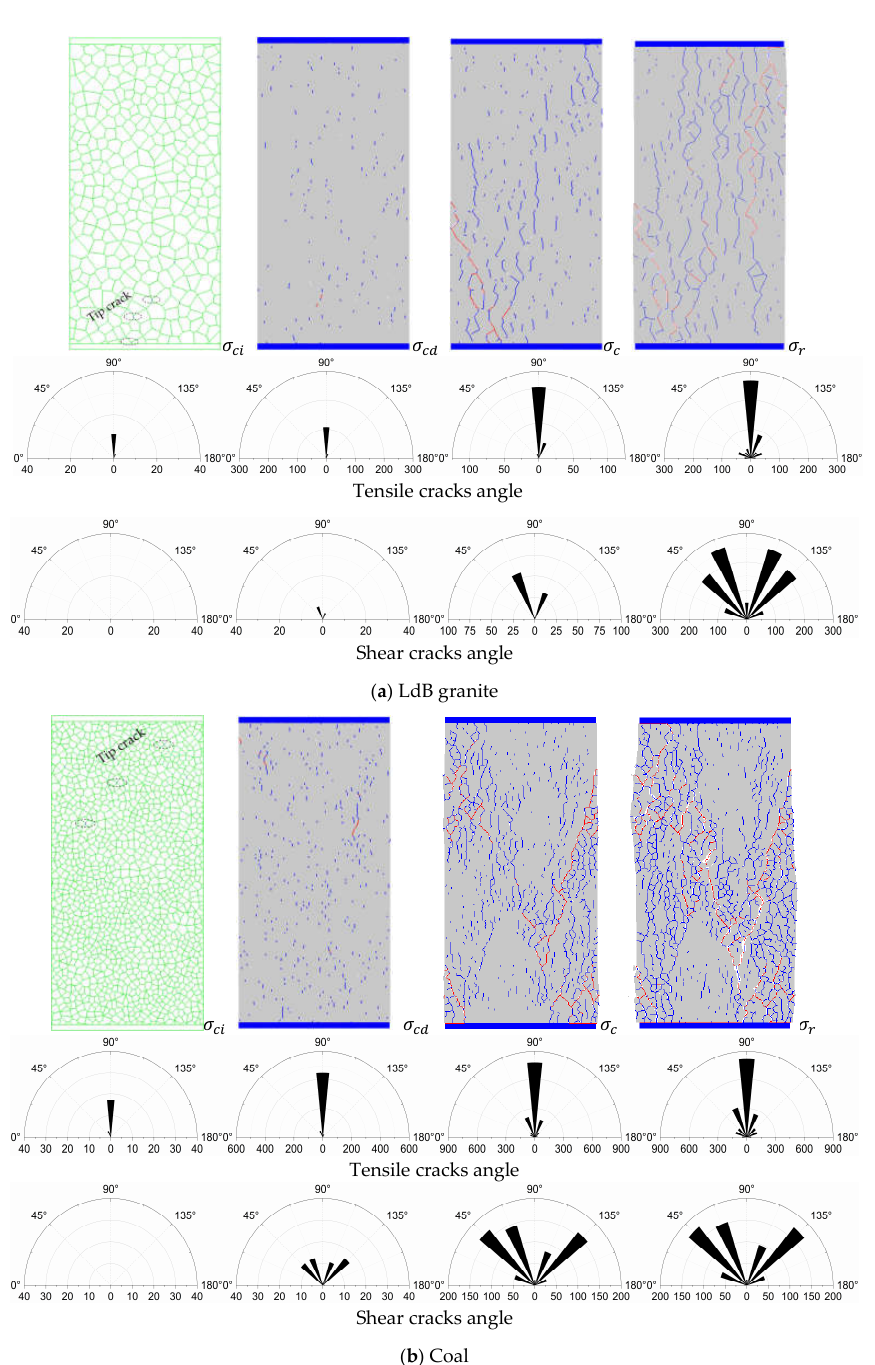
Figure 6. Crack evolution and crack angle statistics during hard rock and weak rock fracture: ( a ) LdB granite ( b ) Coal. Note: The blue line represents the tensile crack and the red line represents the shear crack.